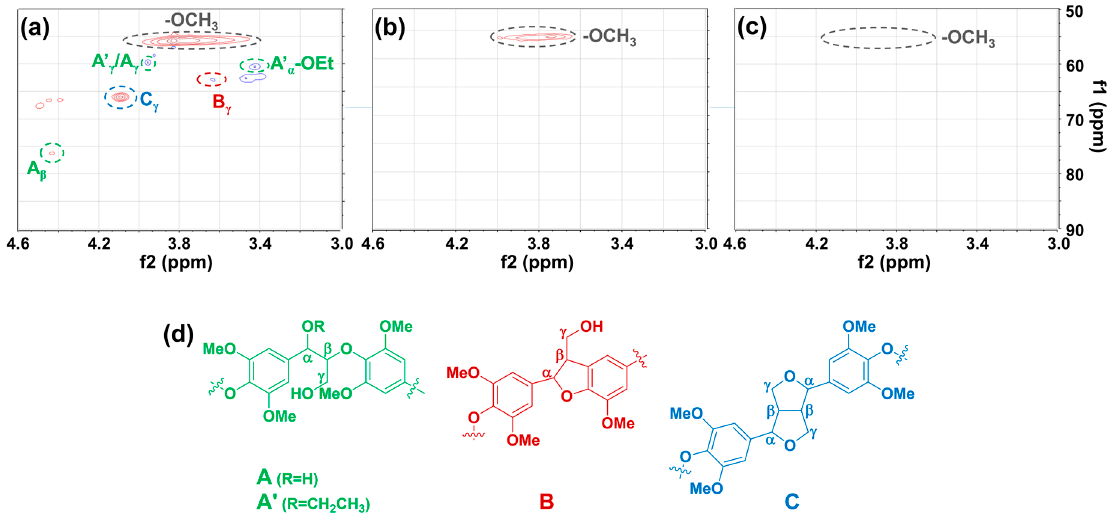
Figure 9. 2D-HSQC-NMR spectroscopy of C–O linkages for ( a ) fresh dealkaline lignin and ( b ) after three hours and ( c ) six hours of hydrogenolysis; ( d ) representative structures of ether linkages for